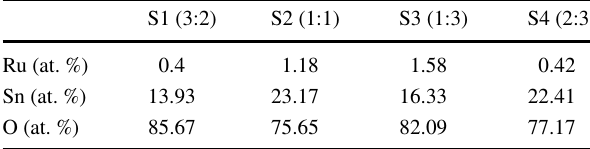
Compositions of Sn, Ru and O obtained from the EDAX